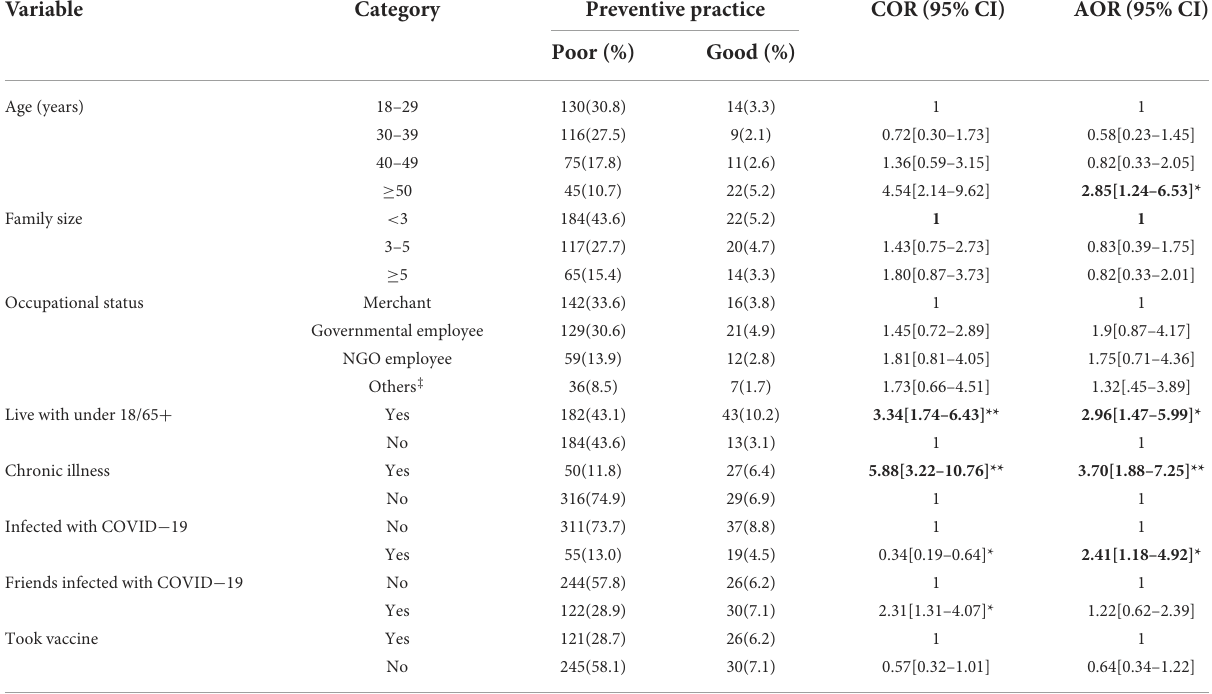
TABLE 5 Bivariable and multivariable analysis of factors associated with COVID-19 prevention practice among respondents at Jimma town 2021, Jimma, Ethiopia.